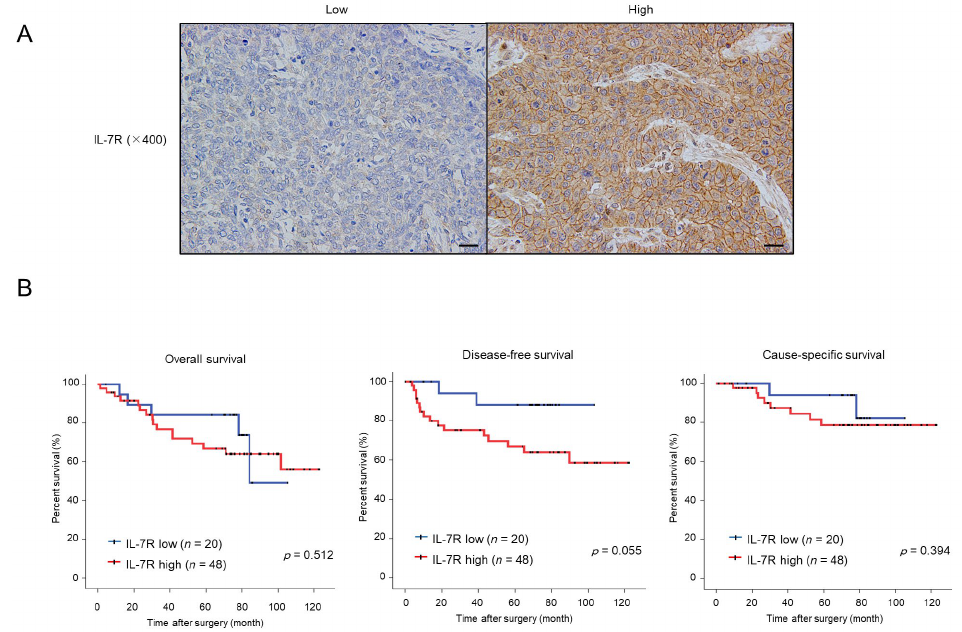
Figure 6. ESCC patients with tumors expressing high levels of IL-7R immunoreactivity tend to have a poor prognosis in terms of disease-free survival. ( A ) Immunohistochemistry for IL-7R was performed with human ESCC tissues. The left and right images show low and high IL-7R intensities in a cancer nest, respectively. Scale bar: 20 µm (400×). ( B ) Correlation between IL-7R expression in ESCC tissues and ESCC patient prognosis. ESCC patients were divided into two groups according to the immunohistochemical intensity of IL-7R: the low-intensity group ( n = 20) and high-intensity group ( n = 48). Kaplan–Meier analysis of ESCC patients with low and high IL-7R expression was performed for overall, disease-free, and cause-specific survival. Data were analyzed using the log-rank test.